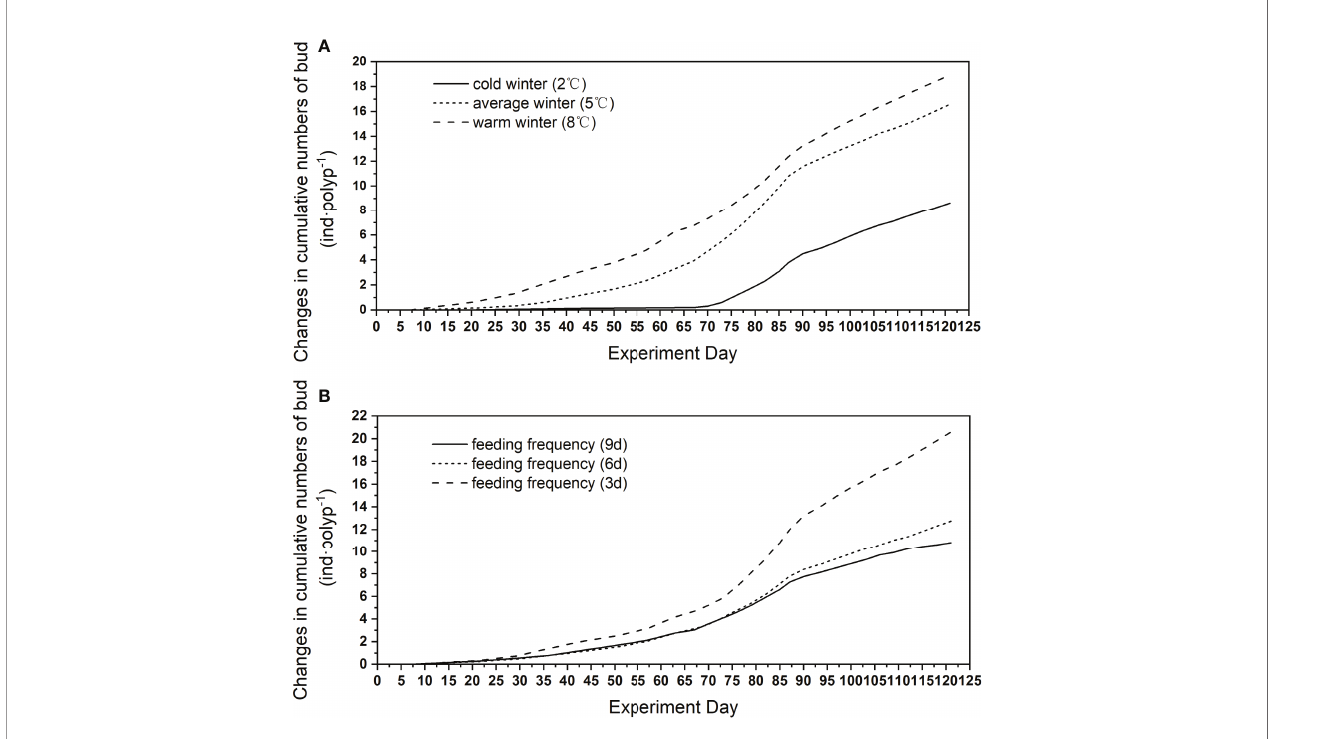
FIGURE 8 | Change in cumulative number of buds at 3 winter temperatures (A) and 3 feeding frequencies (B)